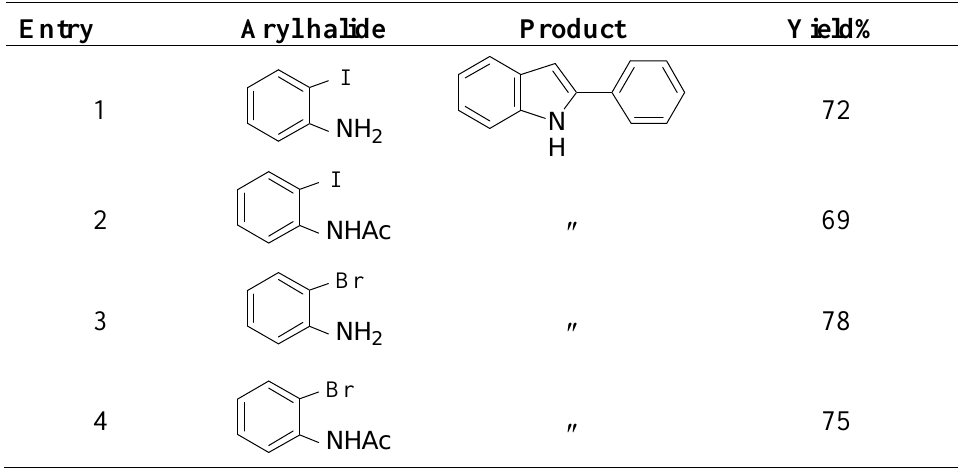
Table 1. Synthesis of 2-substituted indoles by Pd-catalyzed heteroannulation with